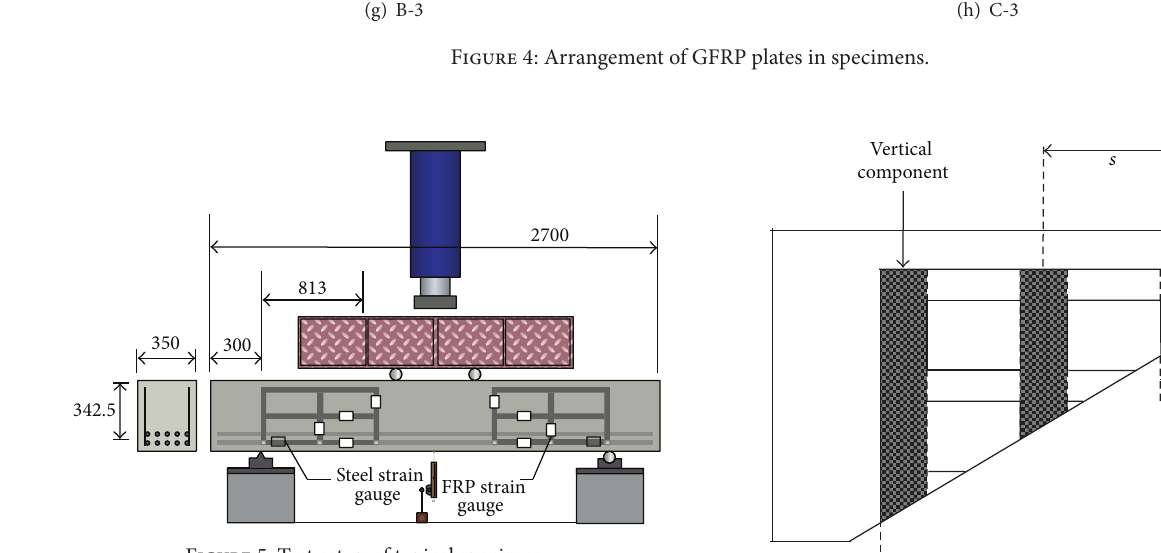
Figure 5: Test setup of typical specimen.